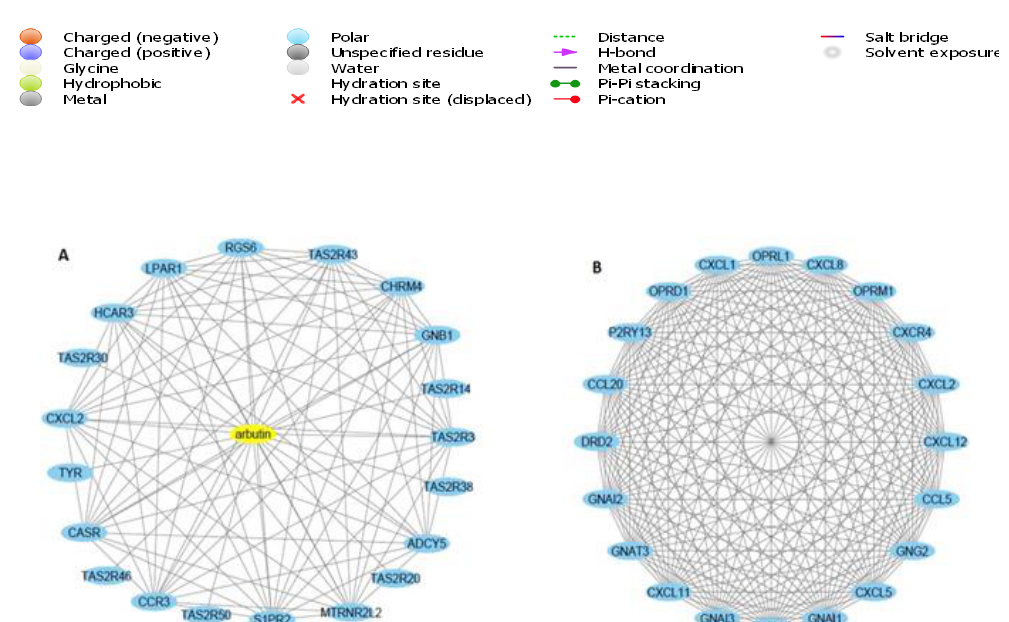
Figure 8. ( A ) CILEx arbutin–target interaction network—the yellow node represents the arbutin and the blue node represents the top 20 proteins—and ( B ) protein–protein interaction (PPI) network of top 20 ranked target proteins.